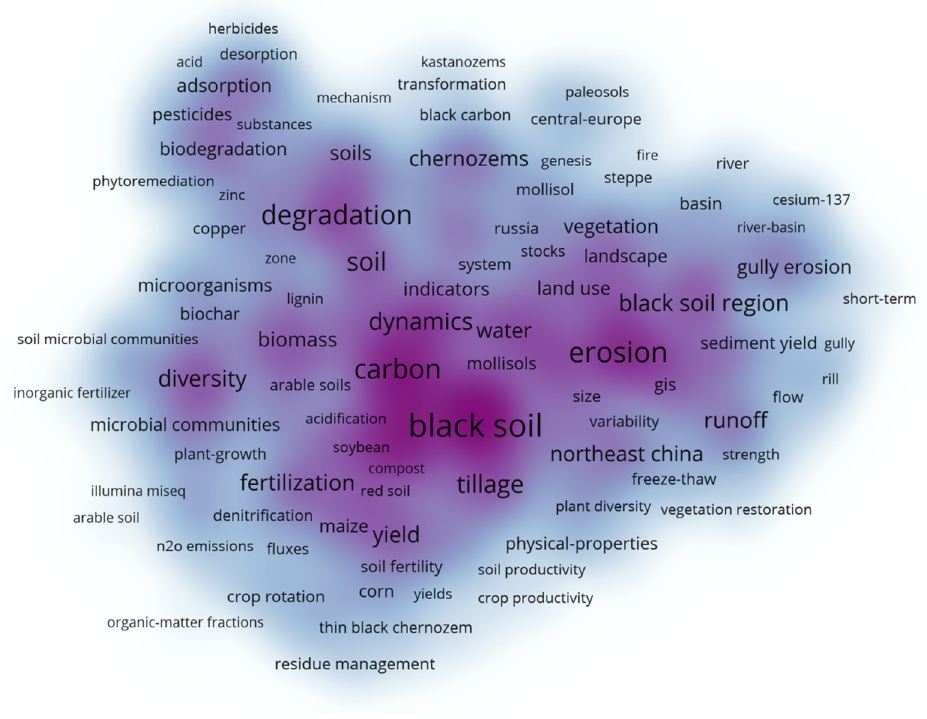
Figure 6. Keyword co-occurrence clustering density view within the BSC research area.